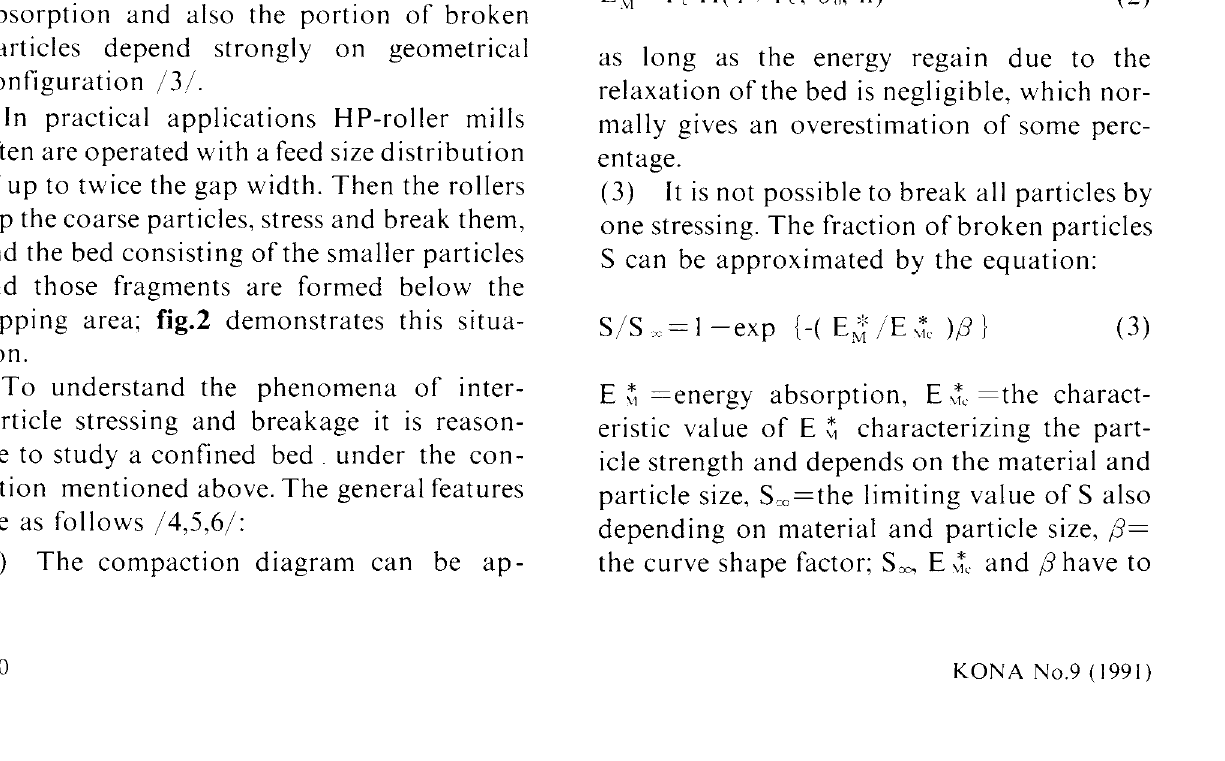
Fig.2 Material bed in tile gap. sketch on